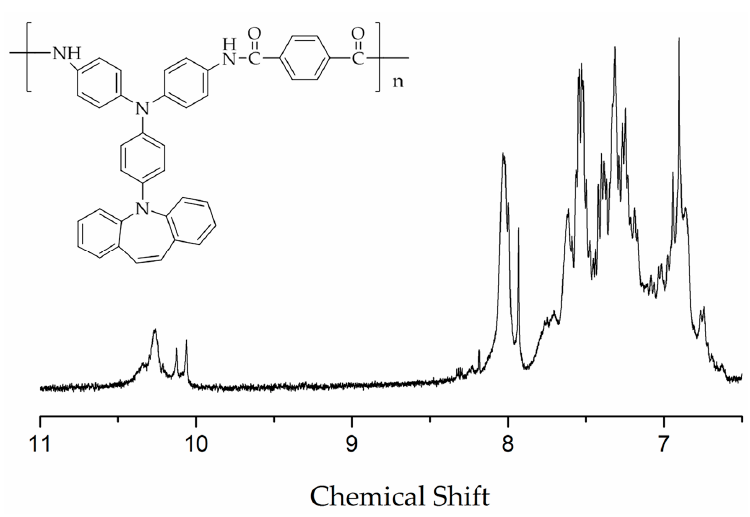
Figure A5. 1 H NMR spectrum of PA–b in DMSO- d 6 .